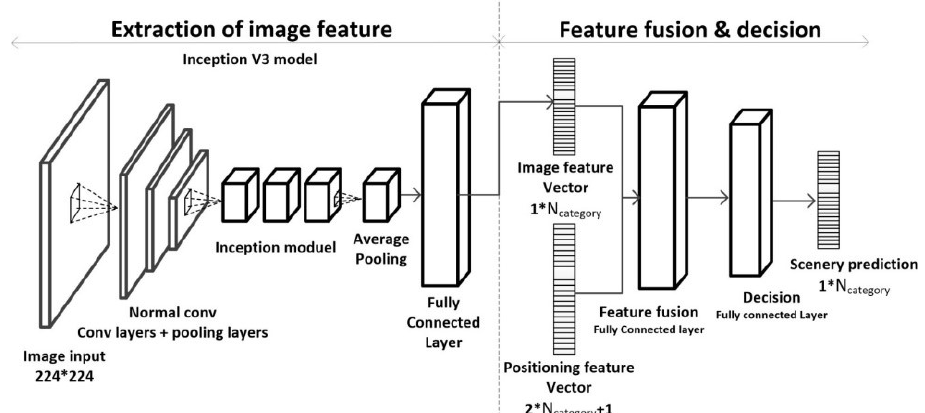
Figure 6. Model chart for the feature fusion model.